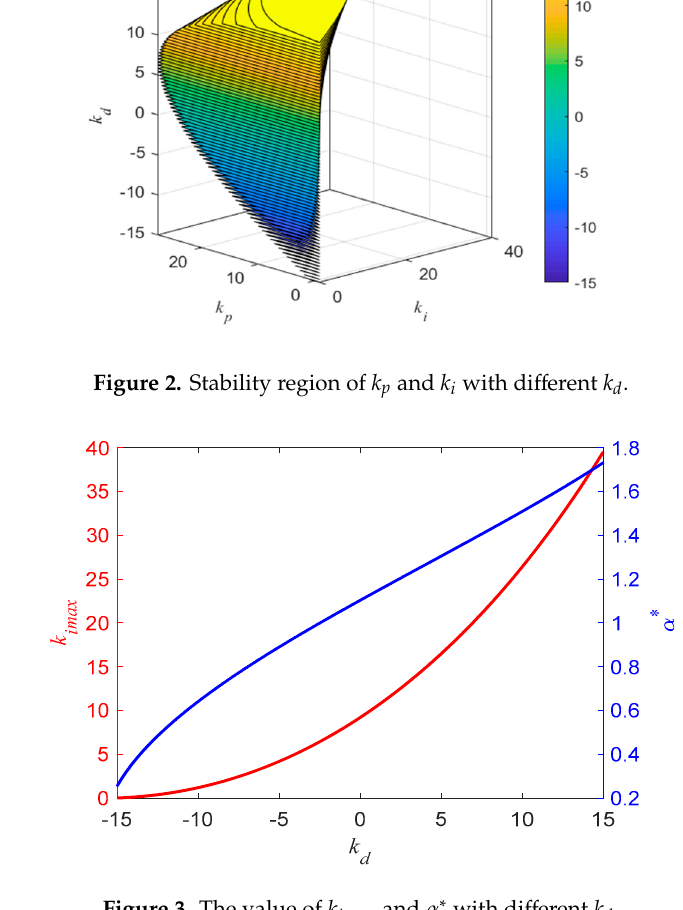
k and * α with different max i i max and